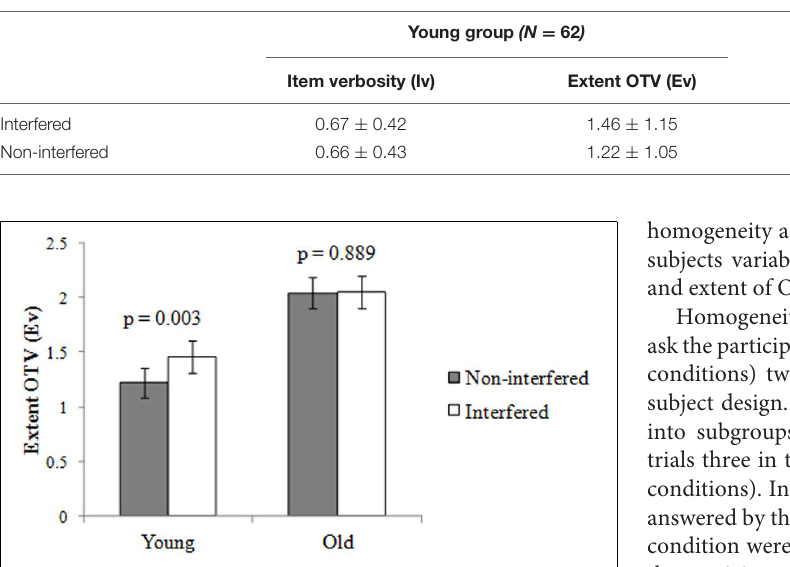
TABLE 2 | Descriptive statistics for OTV in the referential communication task from Experiment 1 ( M ± SD ).